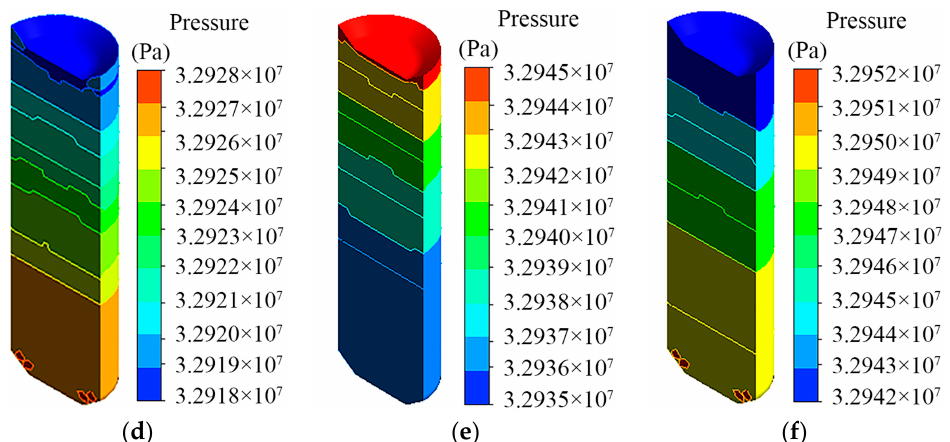
Figure 14. ( a ) Pressure distribution in the fluid domain of the one-level cylinder under condition ( a ). ( b ) Pressure distribution in the fluid domain of the one-level cylinder under impact 0.01 s. ( c ) Pressure distribution in the fluid domain of the one-level cylinder under impact 0.02 s. ( d ) Pressure distribution in the fluid domain of the one-level cylinder under impact 0.03 s. ( e ) Pressure distribution in the fluid domain of the one-level cylinder under impact 0.04 s. ( f ) Pressure distribution in the fluid domain of the one-level cylinder under impact 0.05 s.